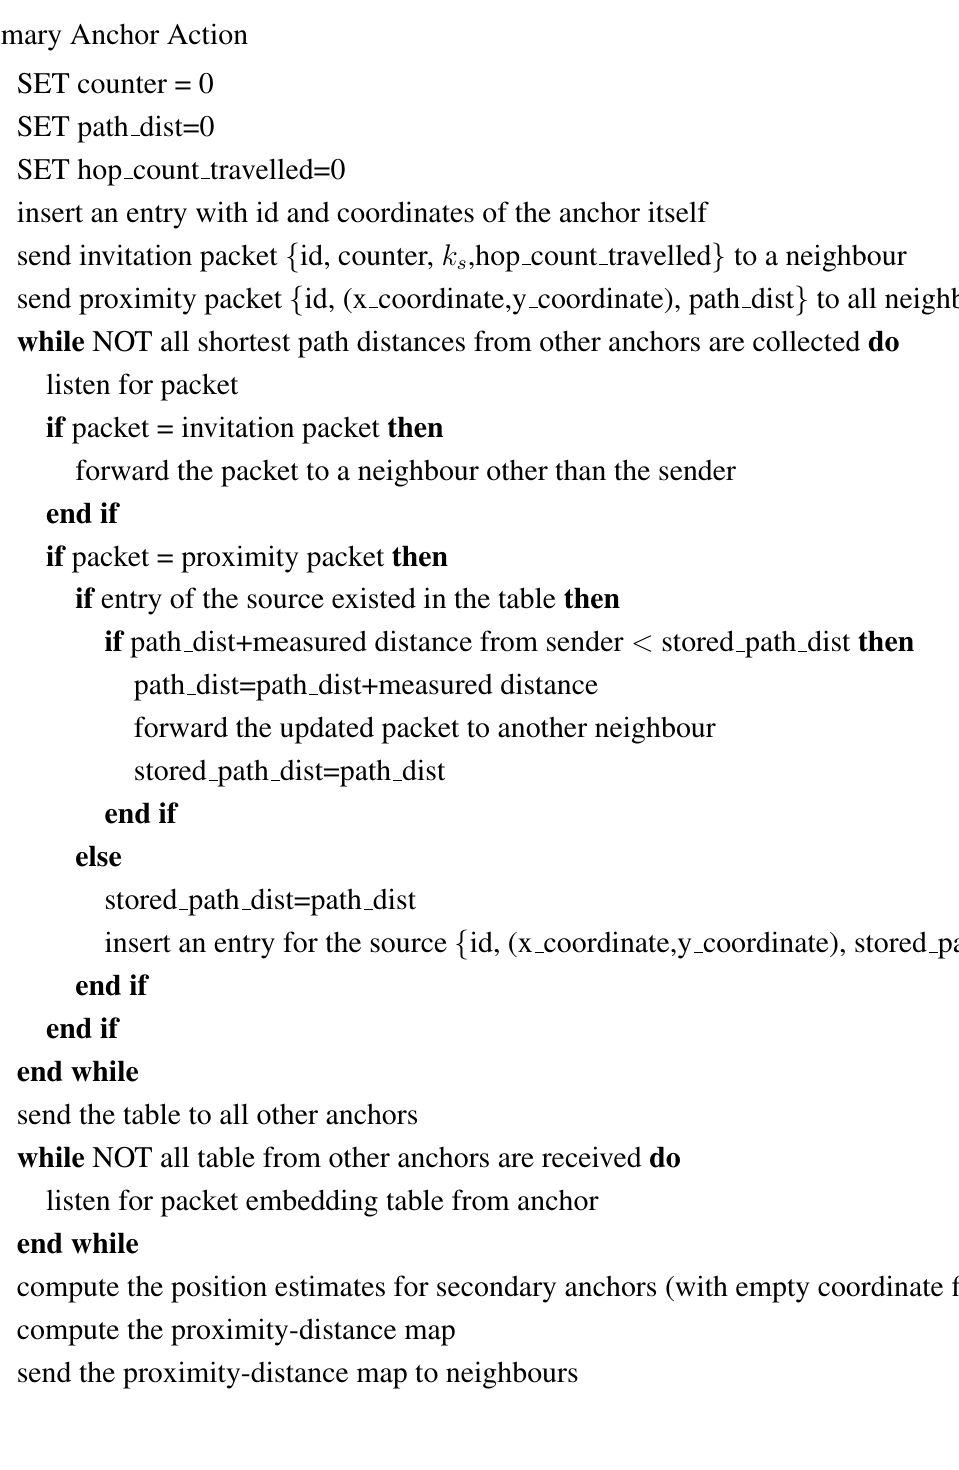
Figure 22 . The Pseudo-Code of a Primary